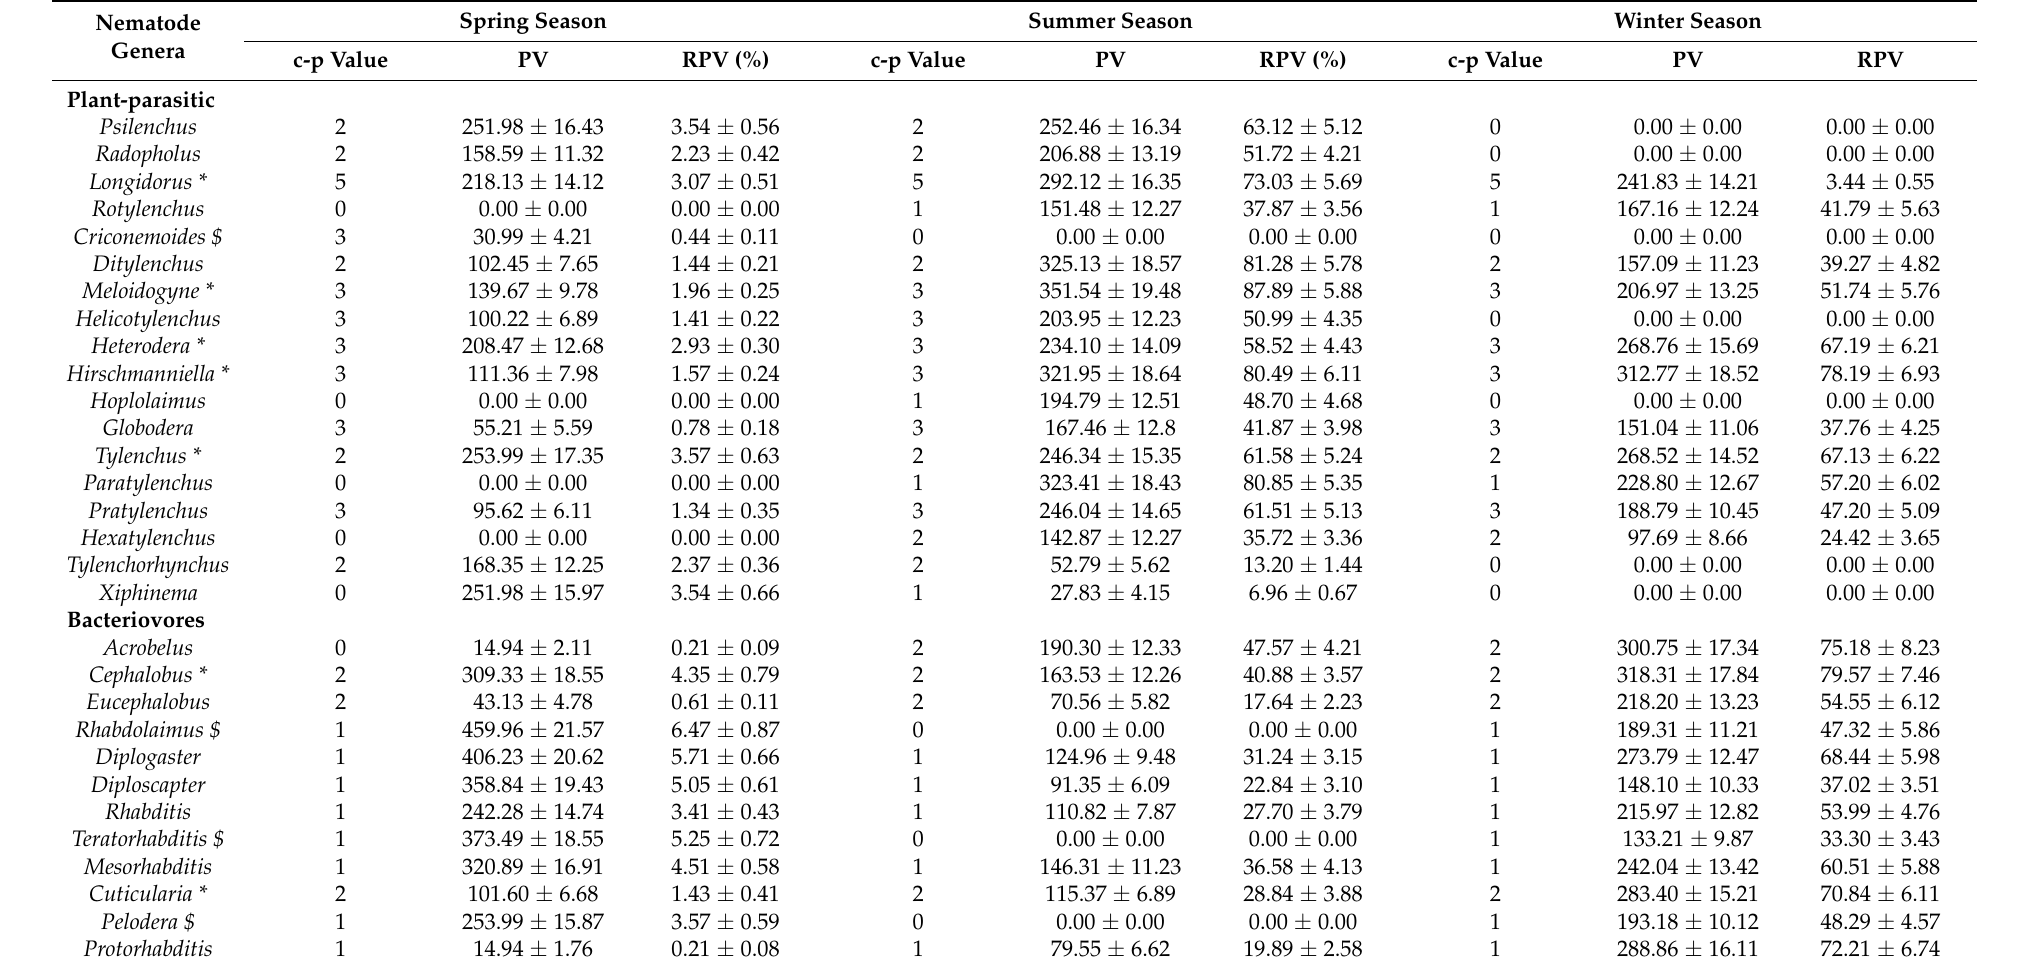
Table 2. The prominence and relative prominence values of the identified soil nematode genera with respective c-p values in the different seasons in the rice